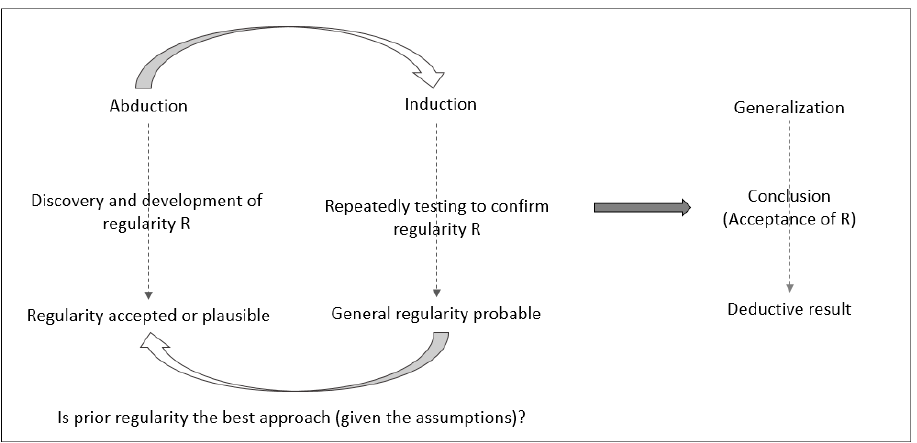
Figure 1. Abductive-inductive process [25]. Reproduced with permission of Rivera, F; Becker, J. R.